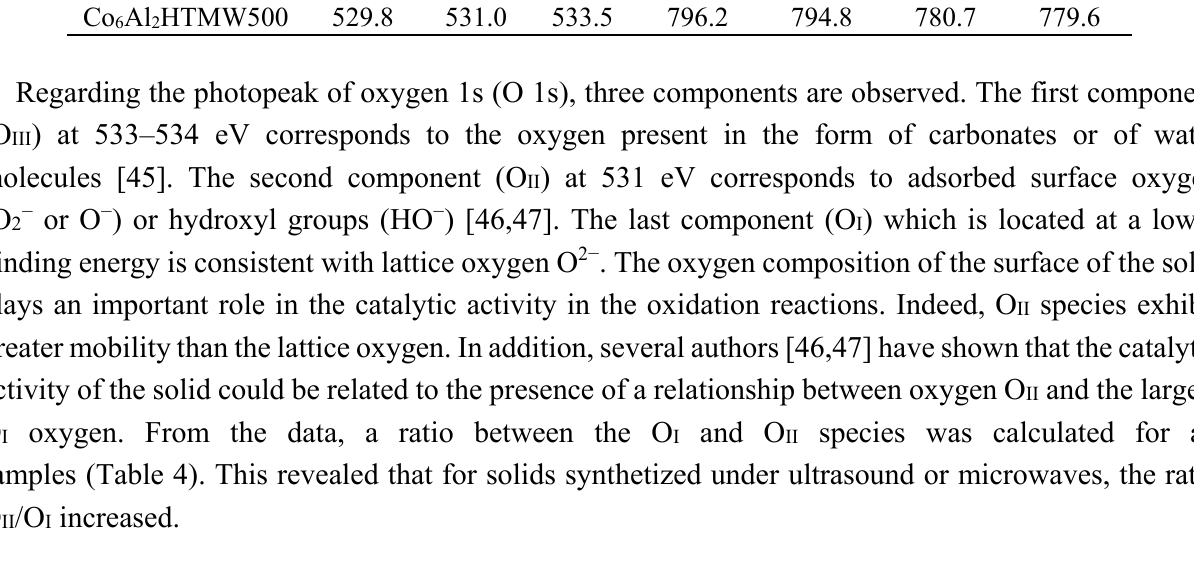
Table 4. XPS data of Co 6 Al 2 HT500 issued from different preparation methods and catalytic intrinsic activity calculated at 10% toluene